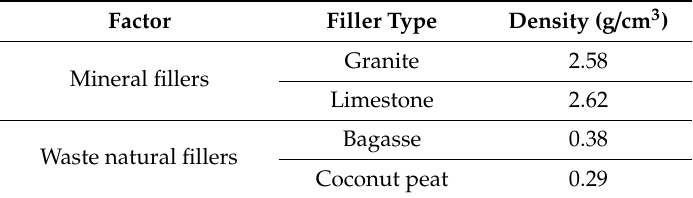
Table 1. Type of filler using in this